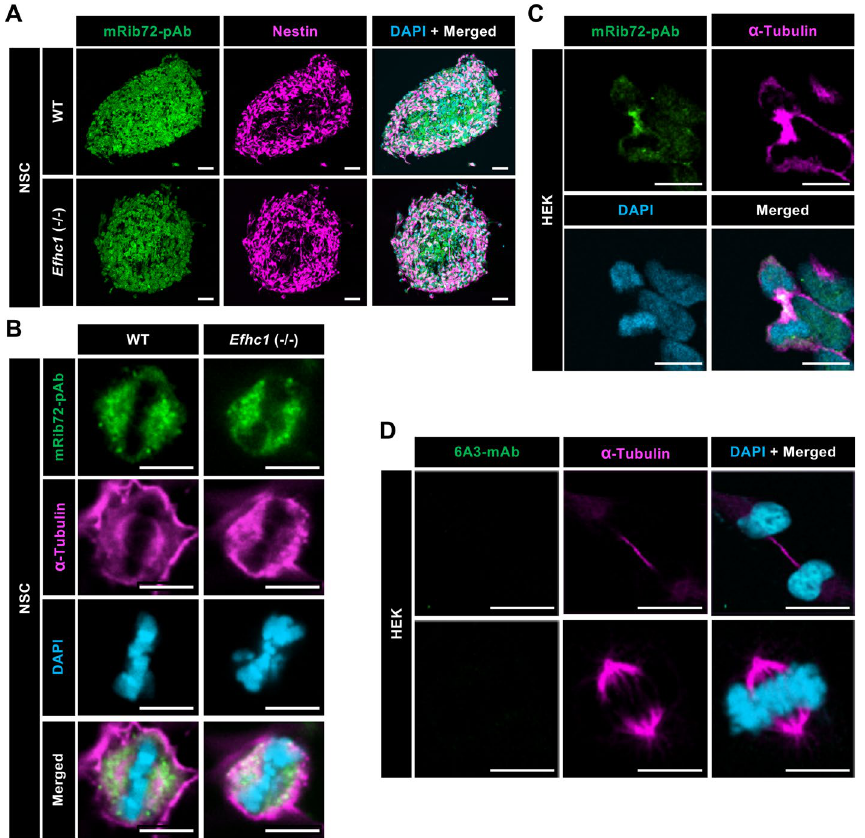
Figure 3. The mRib72-pAb, but not 6A3-mAb, shows immunosignals at mitotic apparatuses that remained in Efhc1 −/− mouse. ( A ) NSC derived from WT and Efhc1 −/− mouse brains at E14.5 were stained with mRib72- pAb (green), antibody to Nestin (magenta) and DAPI (cyan) (two independent experiments, N = 1 WT and 2 Efhc1 −/− ). Signals of mRib72-pAb were observed in cytoplasm of NSC from both WT and Efhc1 −/− mice. N = 3 WT and 4 Efhc1 −/− spheres. ( B ) During cellular mitosis, NSC were stained with mRib72-pAb (green), antibody to α-tubulin (magenta) and DAPI (cyan). Signals of mRib72-pAb were observed in mitotic spindle in cells from WT as reported previously 14 , but remained in Efhc1 −/− . N = 13 WT and 6 Efhc1 −/− cells. ( C ) HEK cells were stained with mRib72-pAb (green), antibodies to α-tubulin (magenta) and DAPI (cyan) (two independent experiments). Midbody was stained with mRib72-pAb and α-tubulin. ( D ) HEK cells were stained with 6A3-mAb (green), antibody to α-tubulin (magenta) and DAPI (cyan) (two independent experiments). The 6A3-mAb did not show signals in midbody and mitotic spindles. Scale bars = 40 μm ( A ), 6 μm ( B ), and 10 μm ( C , D